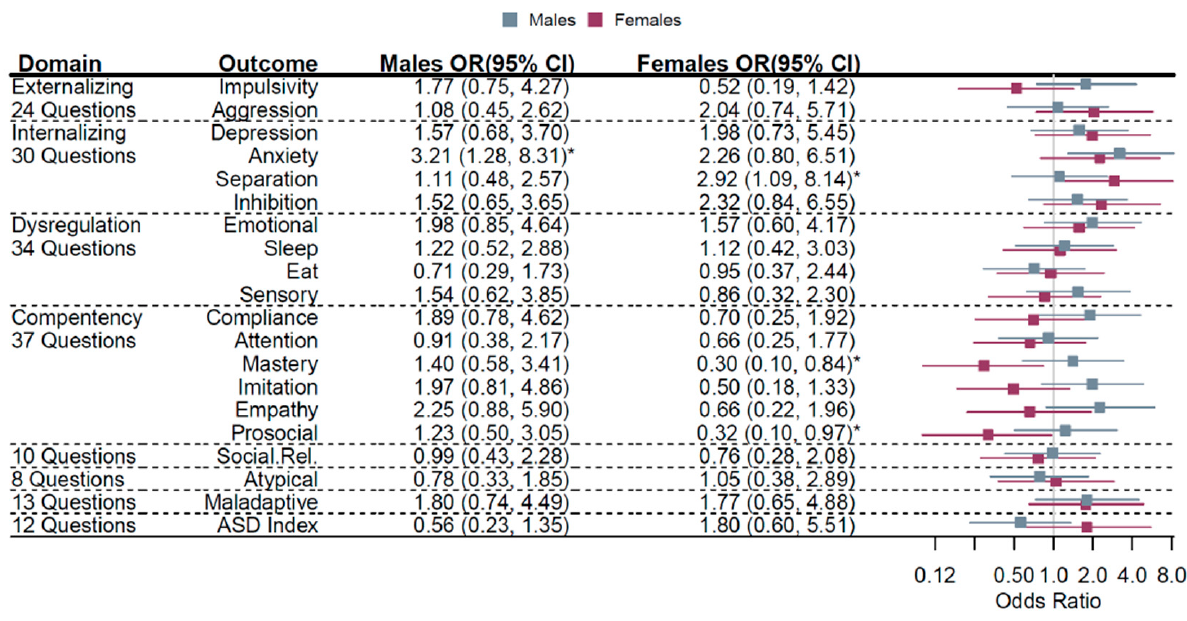
Figure 2. Sex ‐ specific associations of MGL (T2 vs. T1) and offspring temperament. For a given tertile of MGL, compared to tertile 1 (referent), the odds ratio (95% confidence interval) represents the risk of being in a higher tertile of behavioral outcome. Males (gray) and females (magenta) odds ratios (95% confidence intervals) are plotted. Estimates were adjusted as before stratified by sex. * p < 0.05.